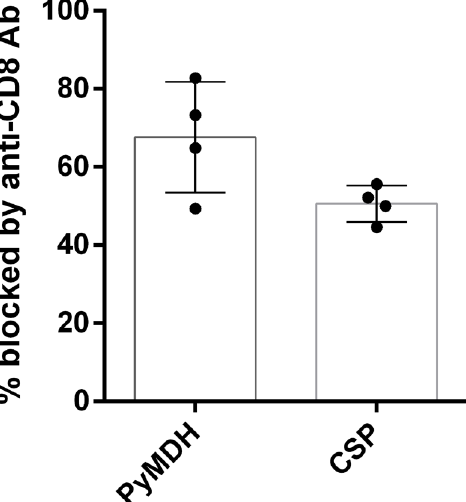
Fig 3. The PyMDH-specific response is CD8 T cell-dependent. ELISPOT wells were treated with anti-CD8 blocking antibody (clone 2.43, final 10 μ g/mL) and compared to isotype-control treated wells. The y-axis shows the percentage reduction in SFU/million splenocytes for antibody-treated versus untreated wells. Splenocytes were from BALB/cj mice immunized with 5x10 4 wild-type P . yoelii sporozoites administered with azithromycin prophylaxis on Days 0 – 2 post-challenge. Bars indicate mean and 95% confidence